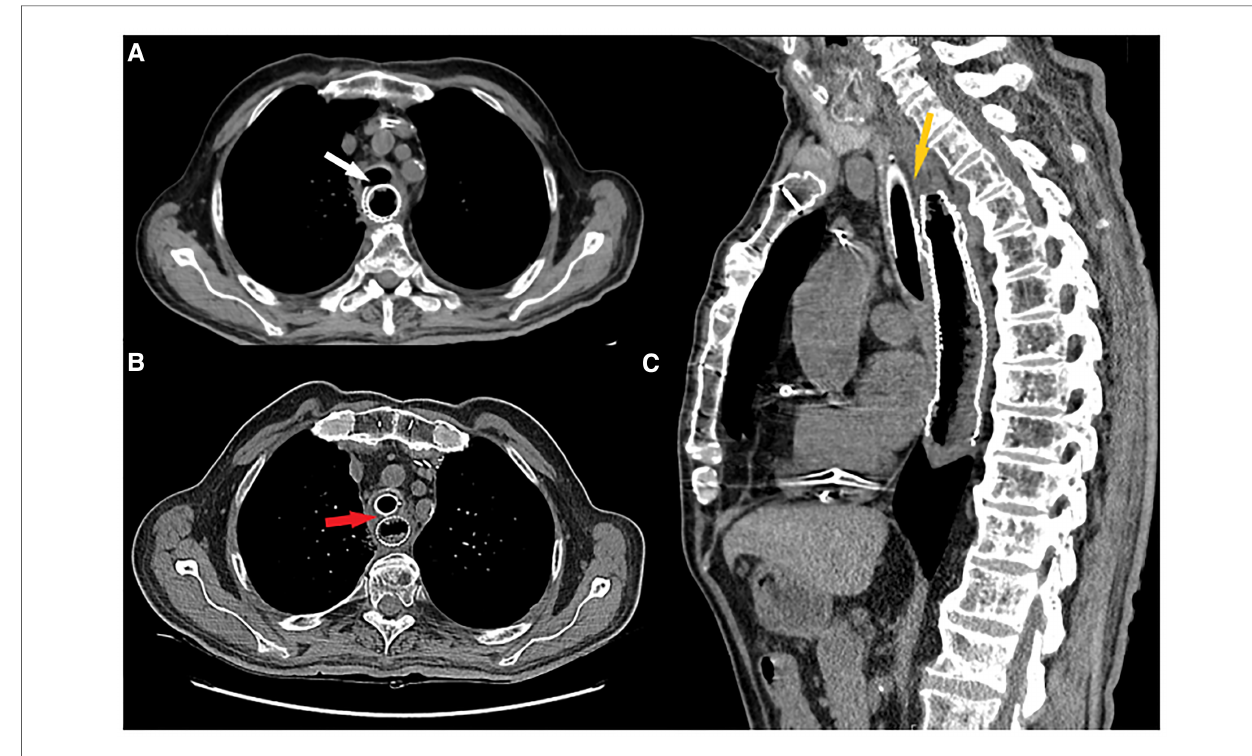
FIGURE 4 ( A ) Preoperative axial CT scan showing esophageal stent protruding inside tracheal lumen (white arrow). ( B ) Postoperative axial CT scan showing both esophageal and tracheal stent with fascia lata graft between them (red arrow). ( C ) Postoperative sagittal CT scan showing fascia lata graft (low density tissue between the two stents) interposed between the two stents covering the whole length of